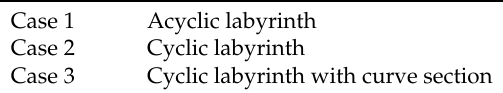
Table 7. List of complete labyrinth cases.